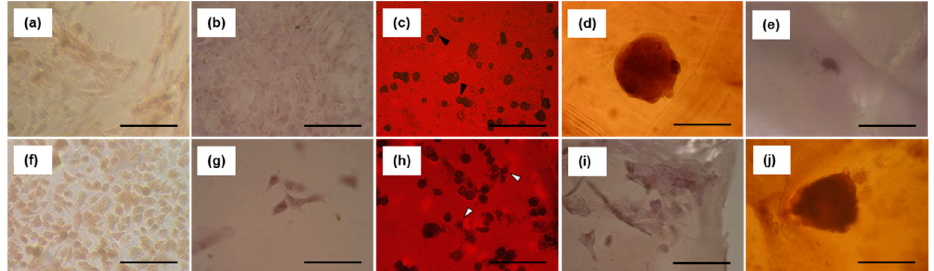
Figure 6. Adhesion of NIH3T3 and A549 cells to polysaccharide composite films and tissue culture- treated polystyrene (TCPS) plates after 3 days of culturing. Microscopic images of NIH3T3 cells ( a – e ) and A549 cells ( f – j ) seeded on TCPS plate ( a , f ), HEP/CHI film ( b , g ), CS/CHI film ( c , h ), HYA/CHI film ( d , j ), and CMC/CHI film ( e , k ) after 3 days of culturing. Scale bar: 100 µm. Closed arrowheads in ( c ) and open arrowheads in ( h ) indicate round-shaped and stretched cells, respectively.